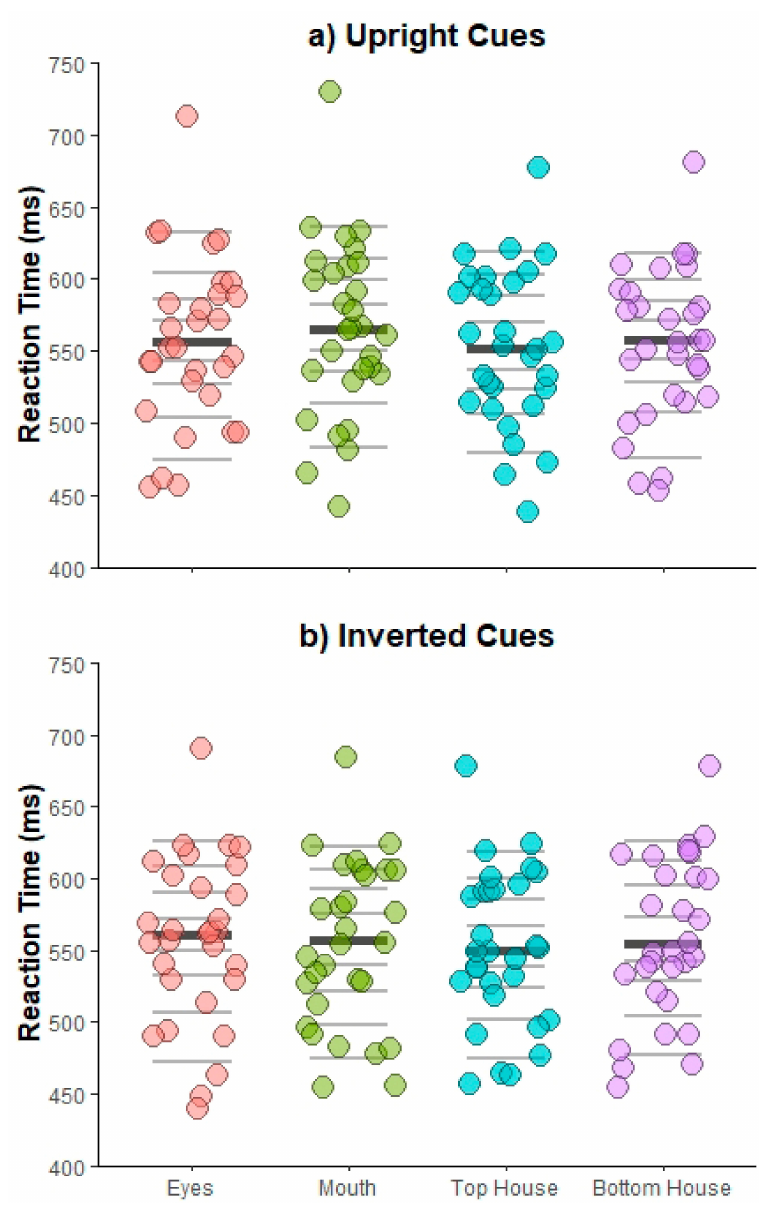
Figure 3. Experiment 1 results. Stripcharts depicting mean correct response times (RTs) for each participant as a function of Target position for Upright ( a ) and Inverted ( b ) cues. Horizontal lines mark the deciles, with the thicker darker line representing the median. Note that the reported pattern of results does not vary even if the outlier is removed from